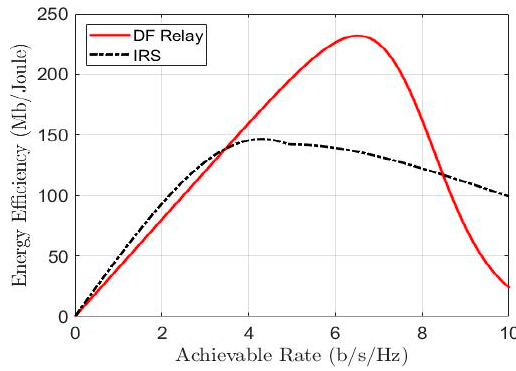
Figure 4. EE of DF Relay vs. IRS.